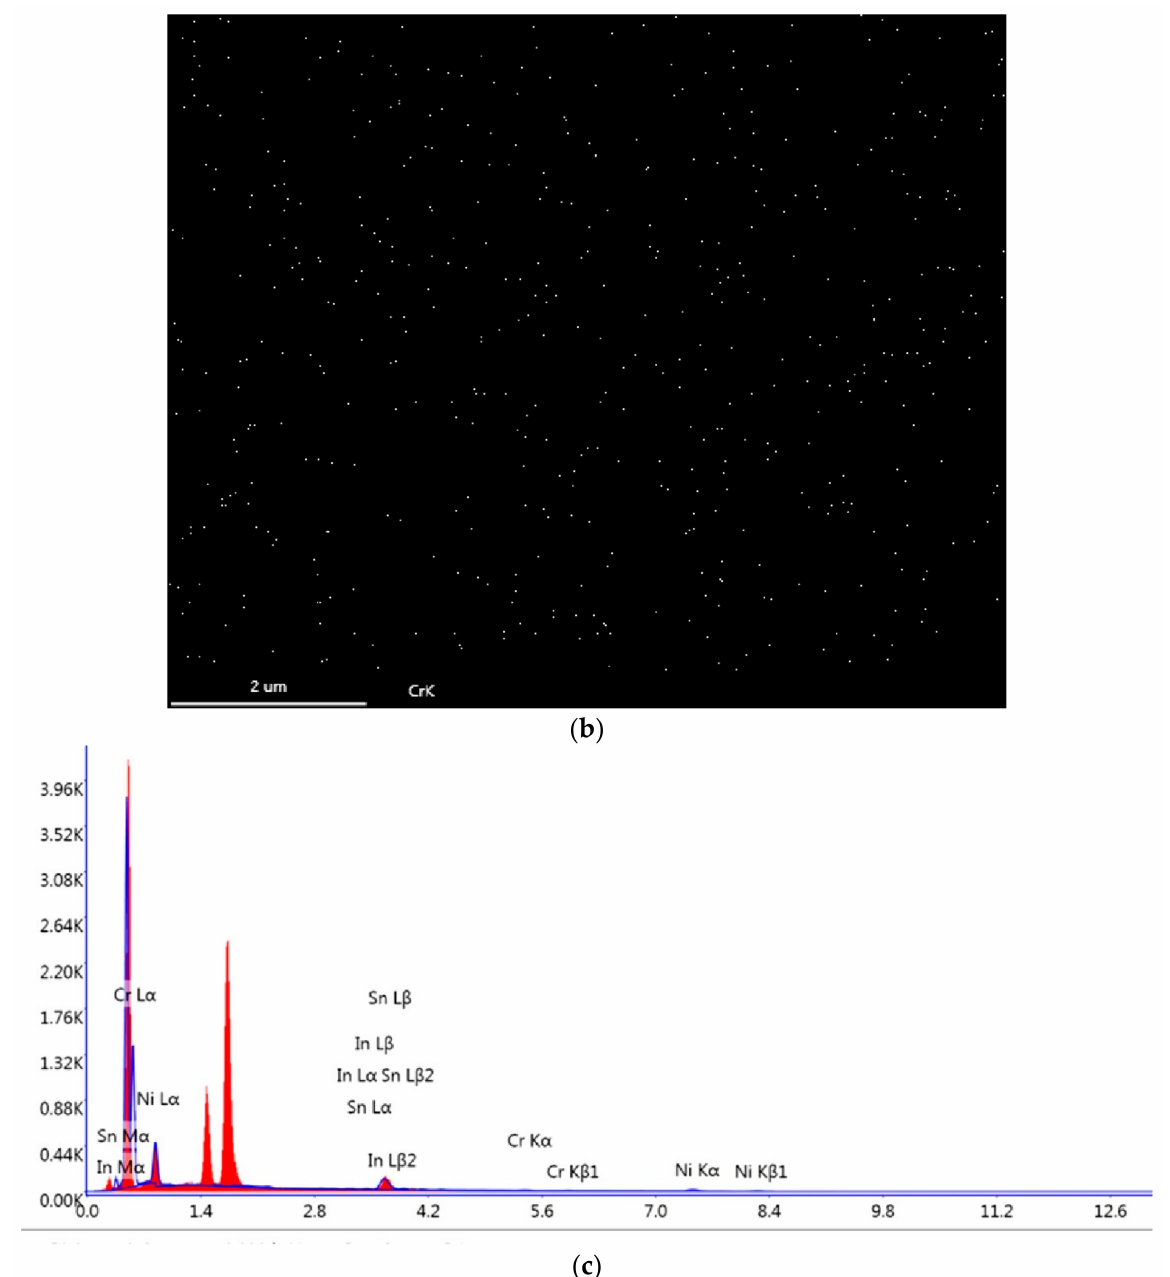
Figure 7. EDS mapping for ( a ) Ni ( b ) Cr and ( c ) EDS data for Cr doped NiO thin